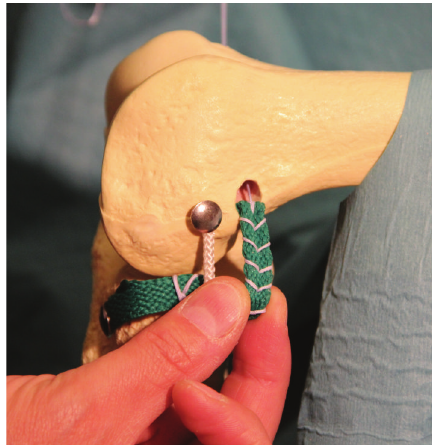
Figure 4: The graft is reinforced with strong, solid-core sutures to avoid graft damage when the interference screw is placed.